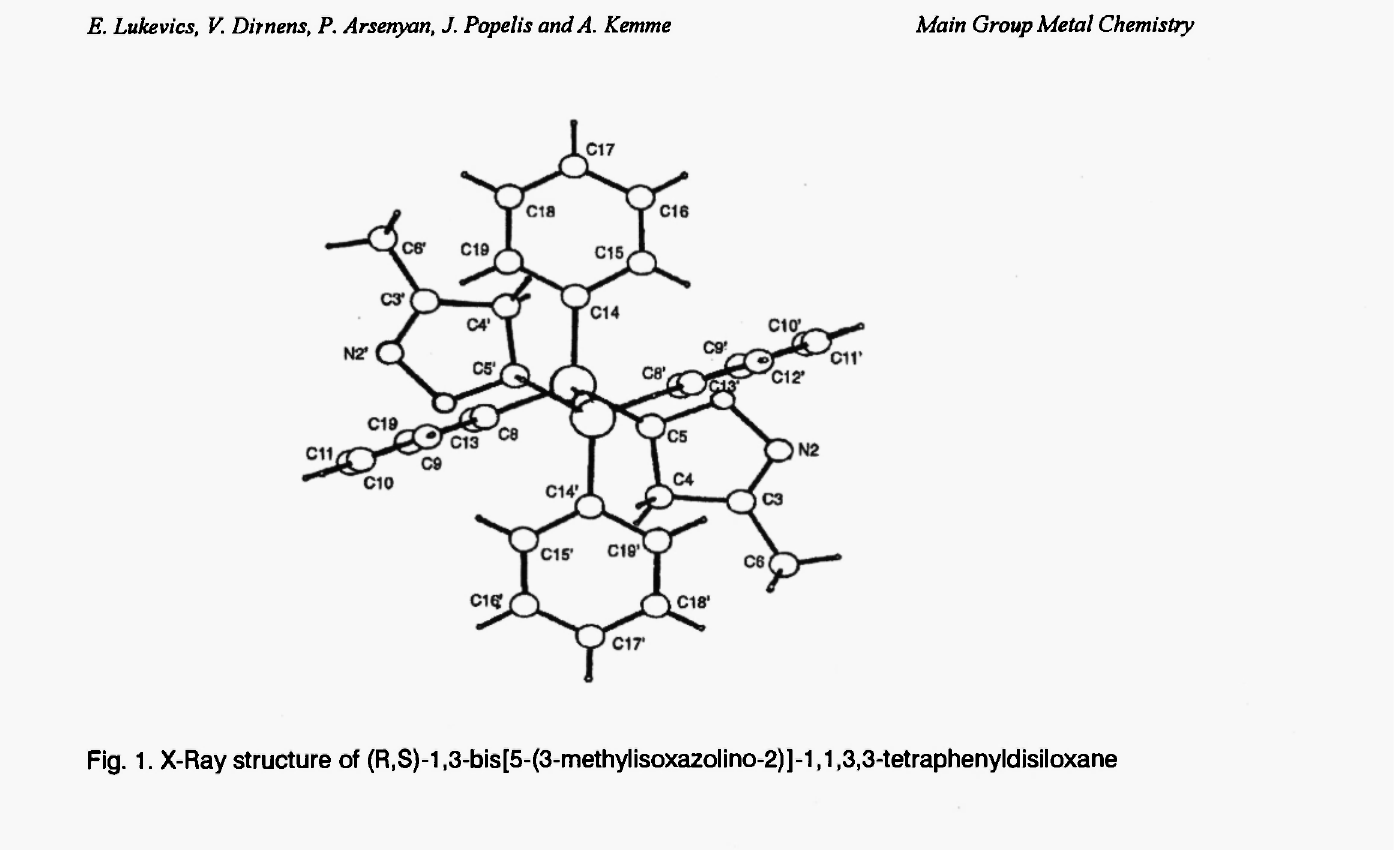
Fig. 1. X-Ray structure of (R,S)-1,3-bis[5-(3-methylisoxazolino-2)]-1,1,3,3-tetraphenyldisiloxane